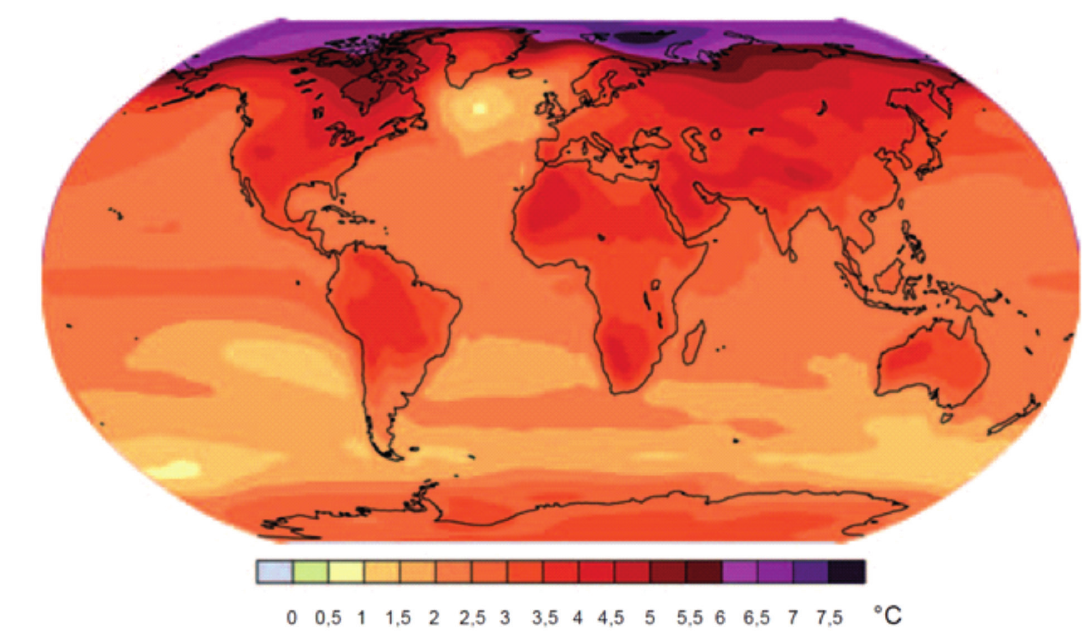
Fig. 1. Anomalies of air temperature at the end of 21st century (2090–2099) in relation to 1980–1999 from several Atmos- phere-Ocean Coupled General Circulation Models (AOGCMs) for A1B emission scenario. Source: IPCC